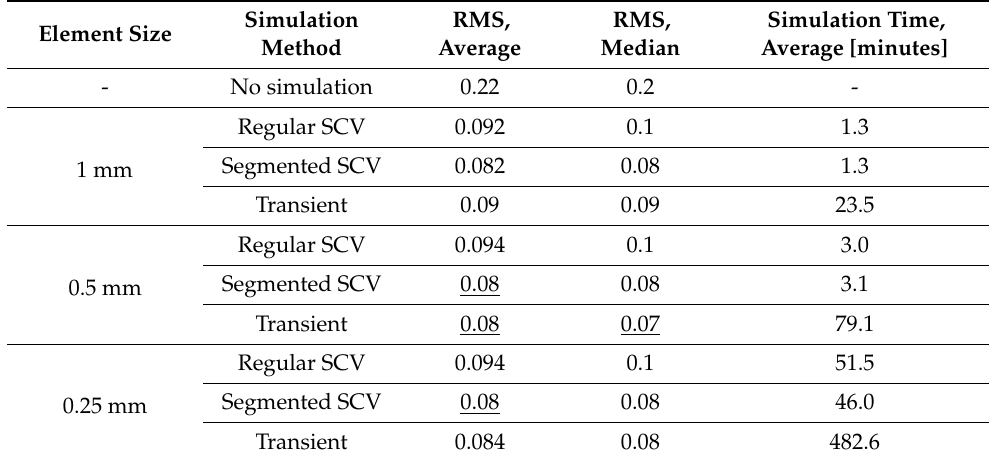
Table 2. The median and average RMS values from the five assemblies indicate the overall perfor- mance of the different element sizes and welding simulation methods. RMS values should otherwise be interpreted in the same way as in Table 1. Simulation times are also shown, indicating the relative simulation